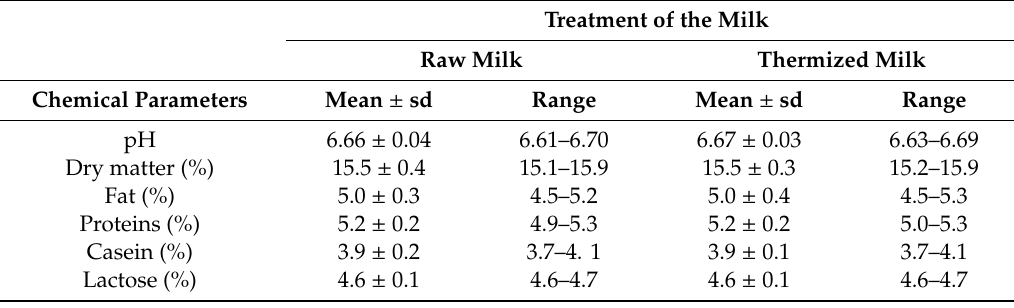
Table 1. Gross composition of raw and thermized sheep milk samples.